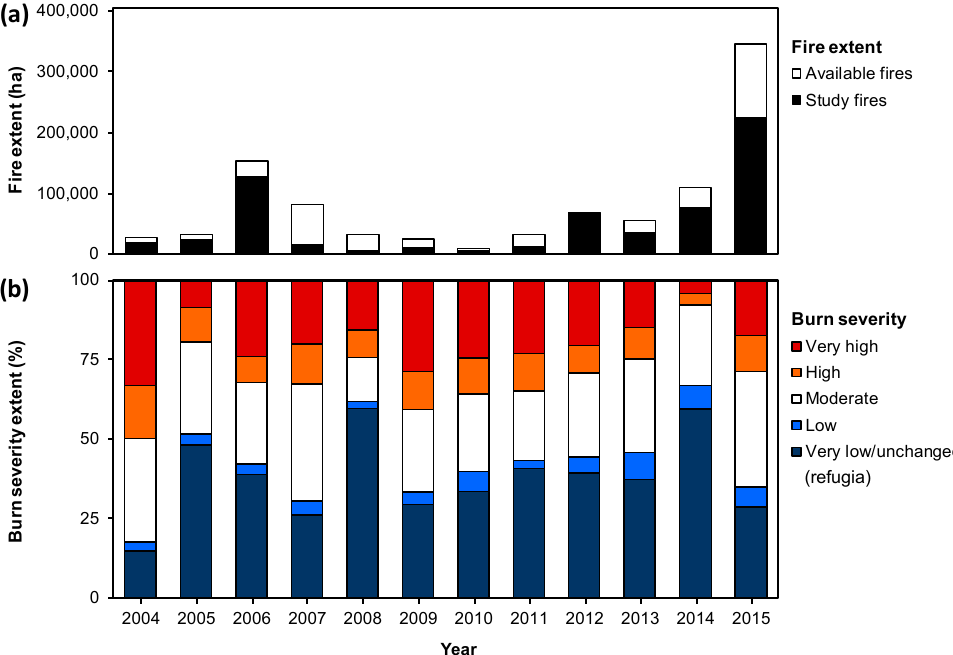
Figure 5. ( a ) Temporal patterns of study fires ( n = 99) and available fires matching study criteria ( n = 172). ( b ) Relative distribution of burn severity classes for study fires across all land cover types. The study fires exhibited the same temporal pattern as the available fires (see spatial pattern in Figure 1). The refugia class (very low/unchanged) was extensive but varied widely from year to year (mean ± SD: 38.1 ± 13.2%). Burn severity classes are based on the relationship between tree basal area mortality at federal inventory plots and Landsat spectral change (RdNBR; Reilly et al. [6]).